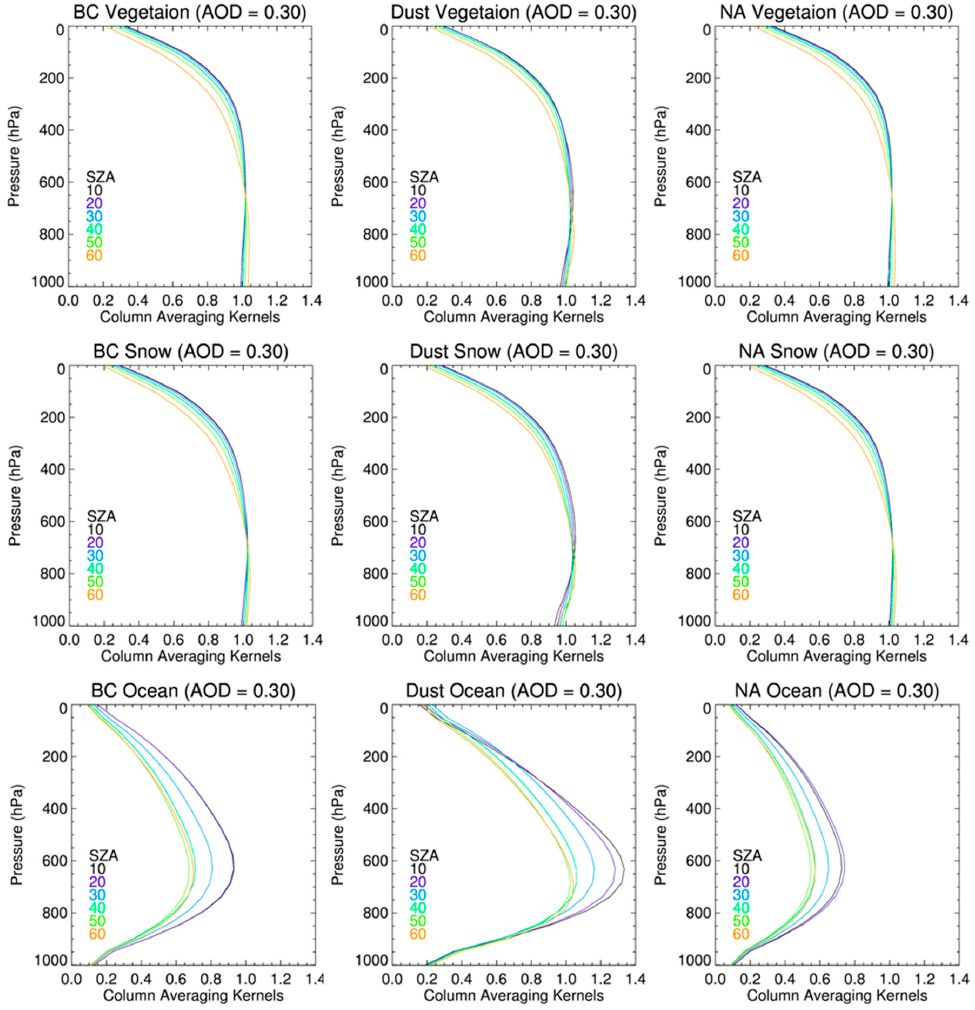
Figure 4. Column averaging kernels for BC ( left column), dust ( middle column) and NA ( right column) aerosol types for an AOD of 0.3 over vegetation ( top panel), snow ( middle panel) and ocean ( bottom panel).